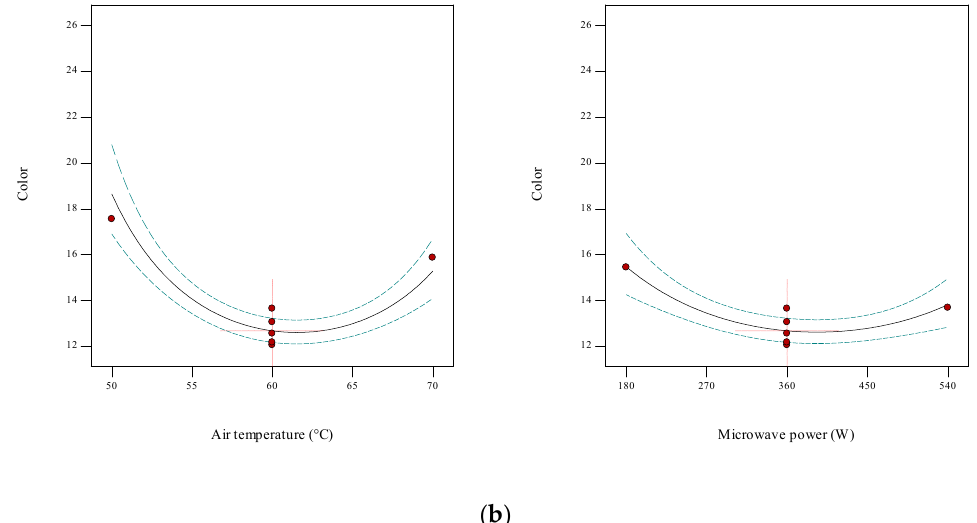
Figure 5. ( a ) The combined effect of air temperature and microwave power on color ( b ) The effect of air temperature and microwave power alone on color.